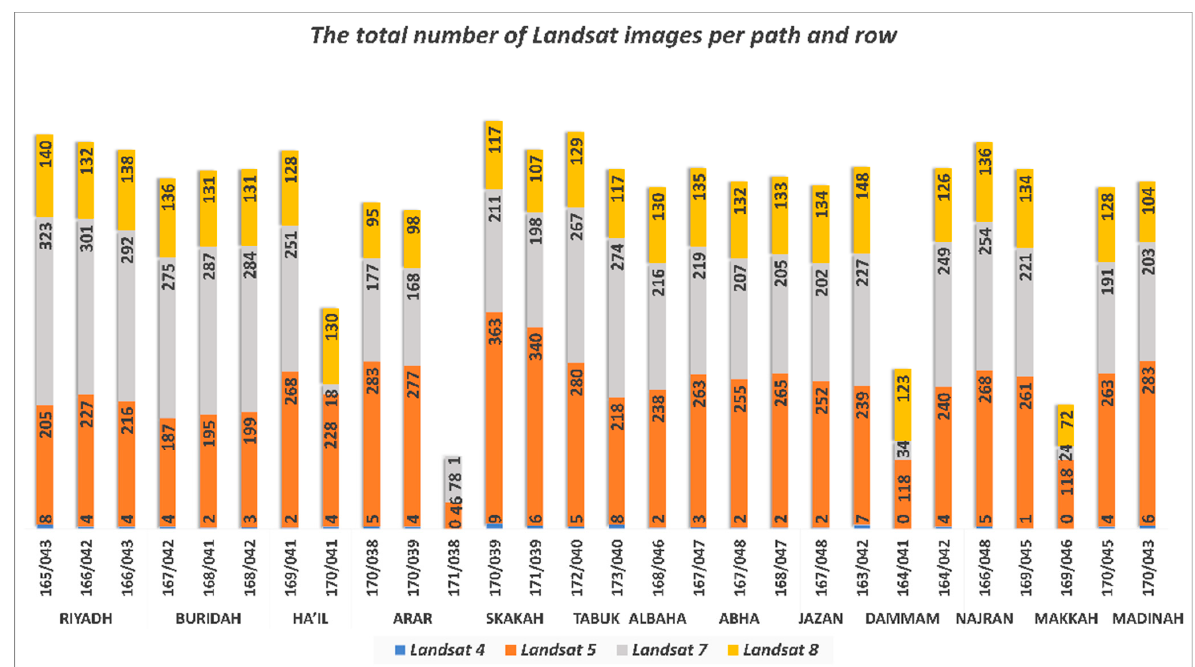
Figure 2. The total number of Landsat images per path and row for each capital (1985–2019).